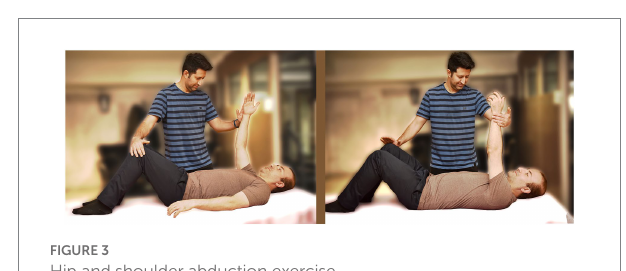
FIGURE 3 Hip and shoulder abduction